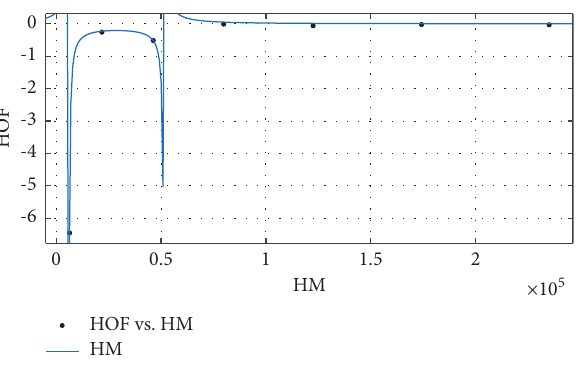
Figure 6: HoF ( HM ) .